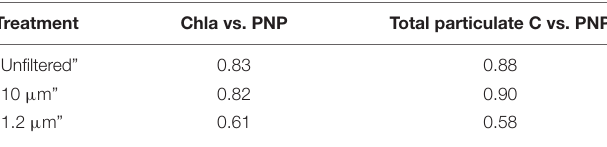
TABLE 5 | Spearman correlation coefficients ( p ≤ 0.005) between chlorophyll a (Chla) or total particulate carbon (C) and particulate non-molybdate-reactive phosphorus